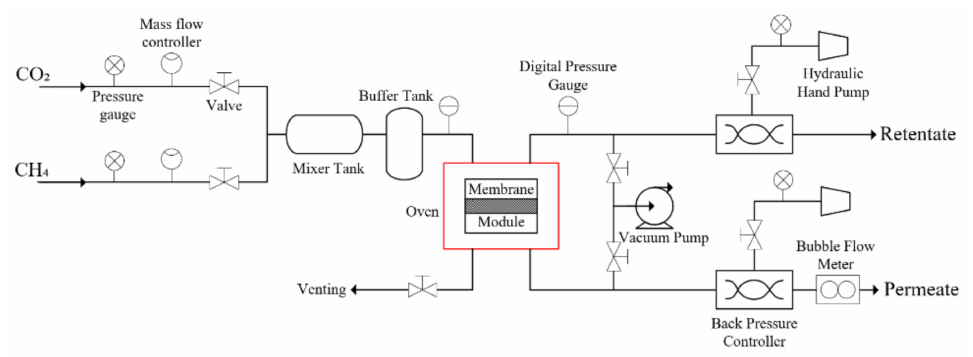
Figure 1. Schematic of the experimental setup used for gas permeation and separation